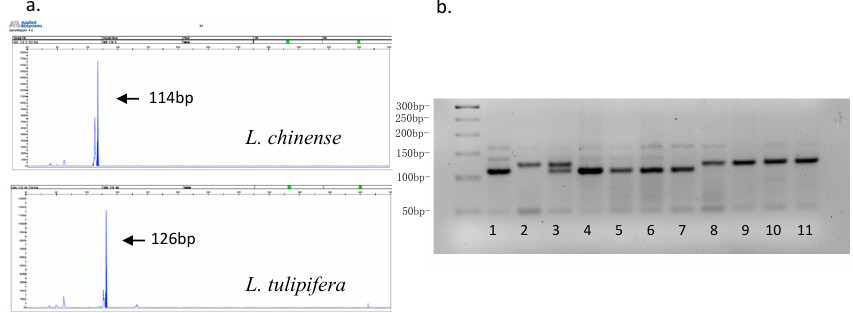
Figure 2. PCR products amplified by expressed sequence tag-simple sequence repeat (EST-SSR) marker (ESSR119) by two methods. ( a ) Peakscanner analysis showed one main peak located at 114 bp in one of the L. chinense individuals and one main peak located at 126 bp in one of the L. tulipifera individuals. ( b ) Representative gel showing amplification profiles of ESSR119 marker and its fragment length polymorphism among four individuals of L. chinense and four individuals of L. tulipifera . The amplifications are resolved in 3% agarose gel along with 50 bp DNA size standard.